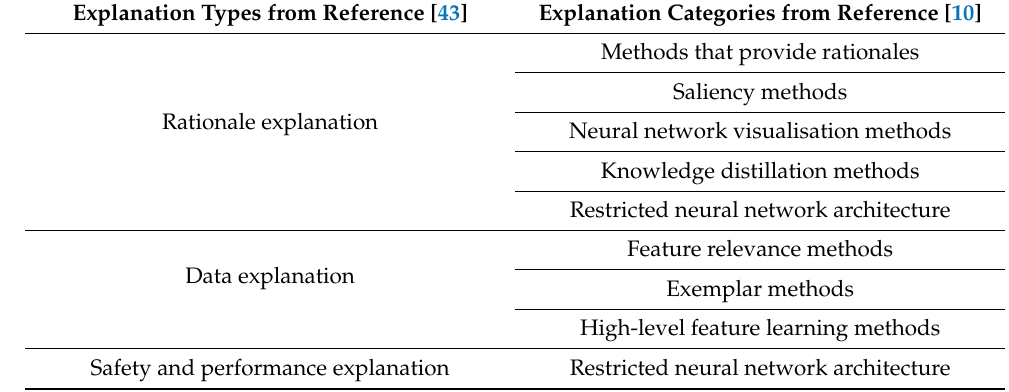
Table 1. Associations between explanation types from Reference [43] and explanation technique categories from Reference